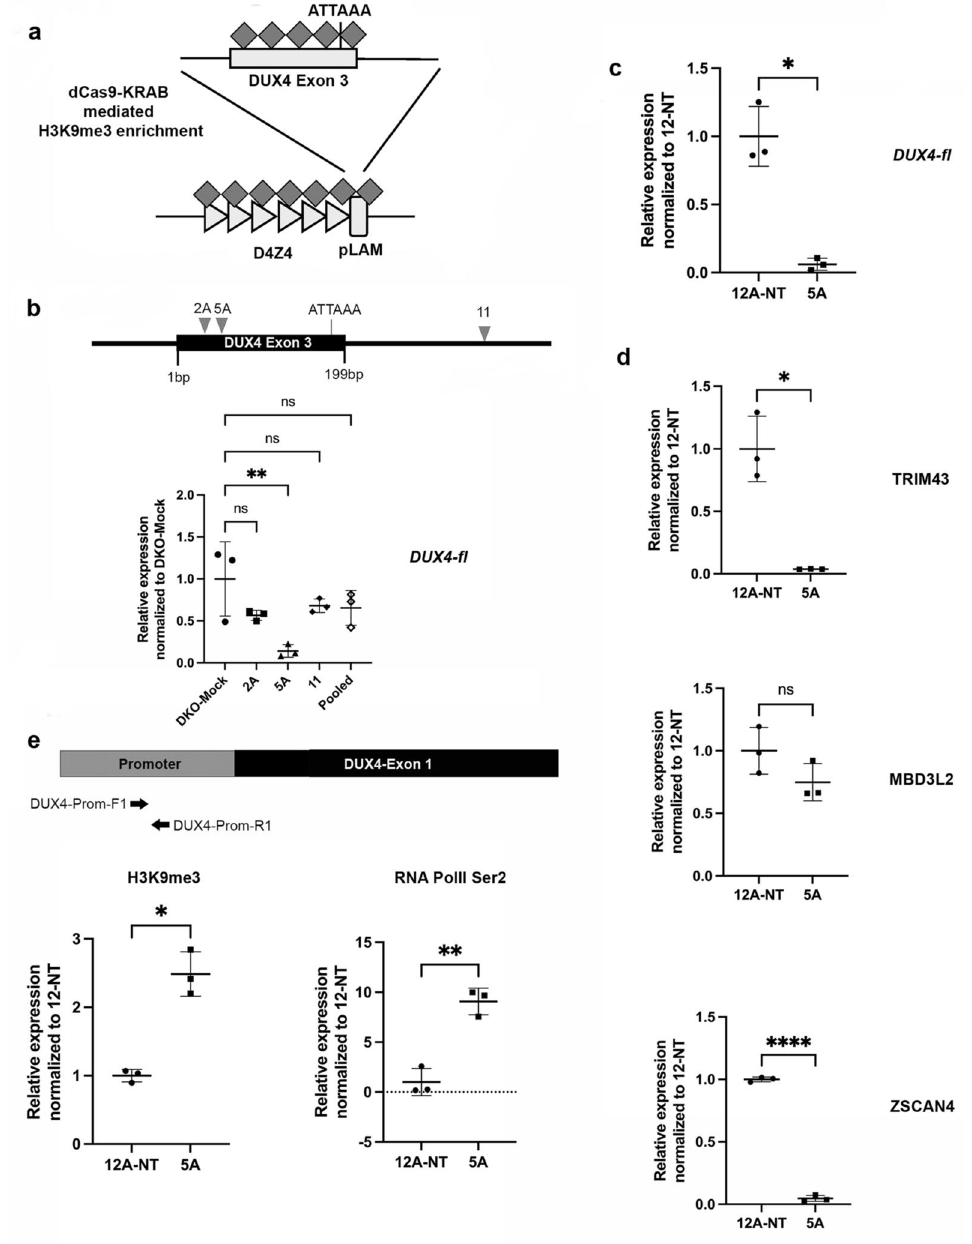
Figure 4. Downregulation of DUX4 and target genes by dCas9-KRAB mediated enrichment of H3K9me3 in patient myoblasts. ( a ) Schematic showing targeting strategy to enrich H3K9me3 and repress DUX4 using a dCas9-KRAB effector recruited by suitable sgRNAs designed at DUX4 exon 3. ( b ) Top panel shows schematic for binding sites of three previously used sgRNAs in DUX4 exon 3. Bottom panel shows qRT-PCR analysis for DUX4-fl in mock (dCas9-KRAB only) and sgRNA-transfected DKO cells. Sample names are indicated on the X-axis. sgRNAs were tested individually as well as a pool. Transcript levels (Y-axis) are expressed as fold change normalized to expression level in mock DKO cells, relative to GAPDH expression. All values are obtained by averaging results from triplicates for each sample. Statistical significance is indicated (** p ≤ 0.01; ns no significant difference; p > 0.05) ( c ) qRT-PCR analysis for DUX4-fl in patient myoblast controls, along with cells treated with the sgRNA (CR-5A) Sample names are indicated on the X-axis. Transcript levels (Y-axis) are expressed as fold change normalized to control (NT) patient myoblasts, relative to ACTB expression. All values are obtained by averaging results from triplicates for each sample. Error bars represent standard deviation (n = 3). Statistical significance is indicated (* p ≤ 0.05). ( d ) qRT-PCR analysis for DUX4 target genes TRIM43 , MBD3L2 and ZSCAN4 control and sgRNA (CR-5A) targeted patient myoblasts. Transcript levels are expressed as fold-change normalized to expression level in control (NT) patient myoblasts, relative to ACTB expression. All values are obtained by averaging results from triplicates for each sample. Error bars represent standard deviation (n = 3). Statistical significance is indicated (* p ≤ 0.05, **** p ≤ 0.0001, ns no significant difference; p > 0.05). ( e ) Results of qPCR for H3K9me3 and RNAPolII-S2 ChIP in control and sgRNA targeted patient myoblasts. Labeled arrows show location of primers in the DUX4 promoter region (grey), relative to the DUX4 ORF (black) within each D4Z4 monomer. Sample names are indicated on the X-axis while enrichment values on the Y-axis are expressed as percentage of corresponding input samples, after normalization with respect to corresponding RS samples. All values are obtained by averaging results from triplicates for each sample. Error bars represent standard deviation (n = 3). Statistical significance is indicated (* p ≤ 0.05, ** p ≤ 0.01). Schematic diagrams were generated using Microsoft PowerPoint 16.48 (https:// www. micro soft. com) and Adobe Photoshop 21.0.1 (https:// www. adobe.